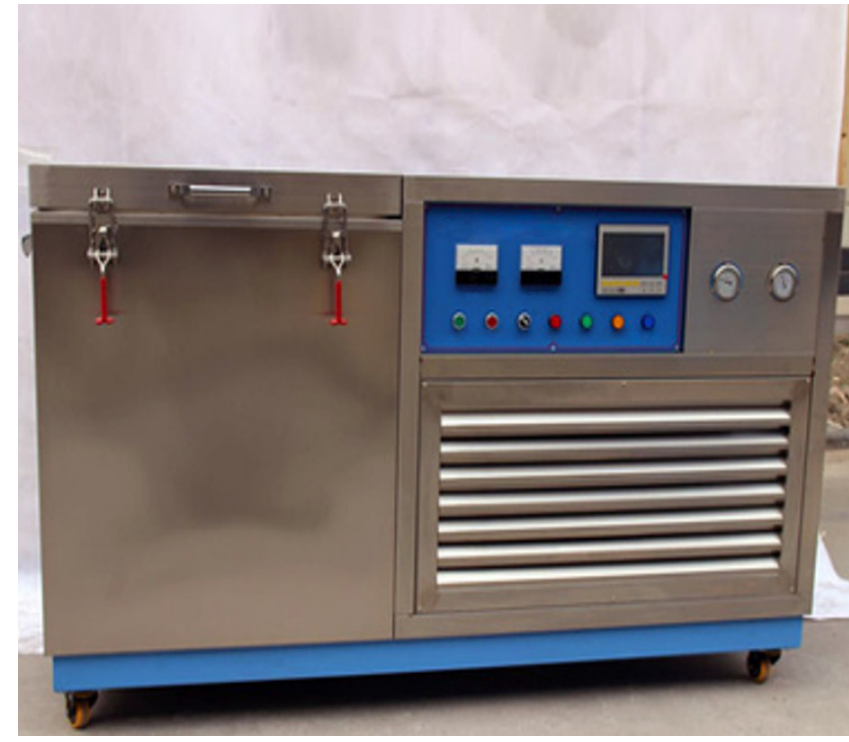
Figure 2. JCD-400 type slow freeze–thaw